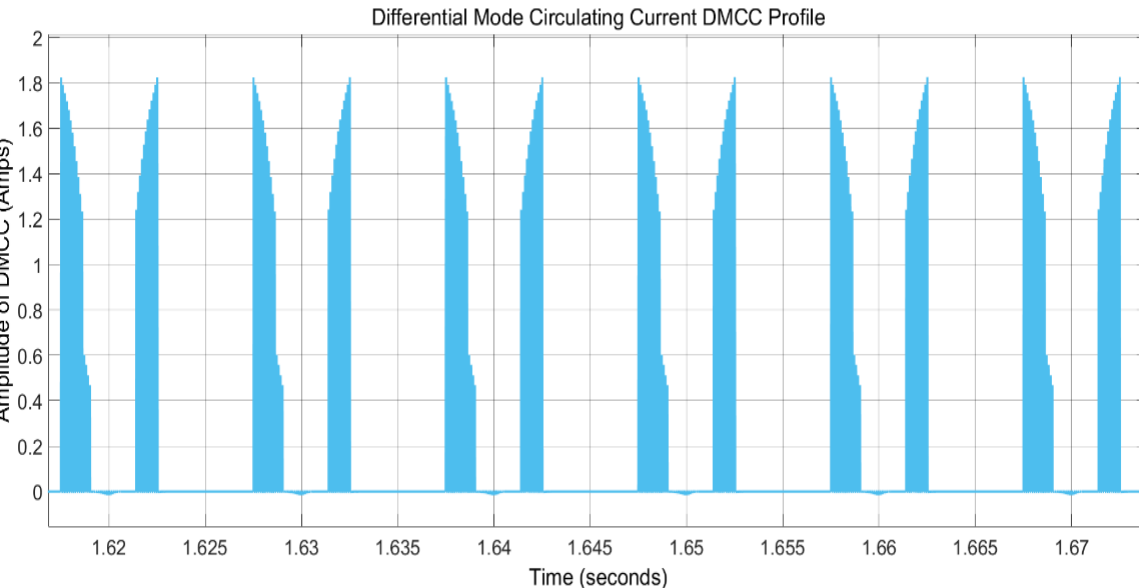
Figure 18. Magnified DMCC profile with AICMC controller.